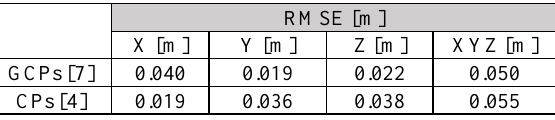
Table 1. Mean errors on GCPs and CPs.